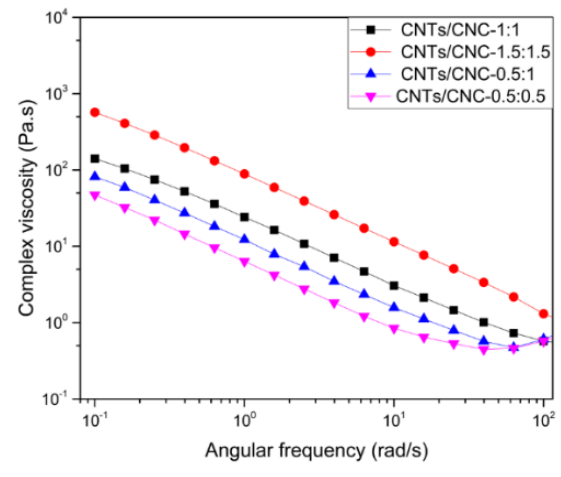
Figure 7. Complex viscosity of CNTs/CNC-based inks versus angular frequency.